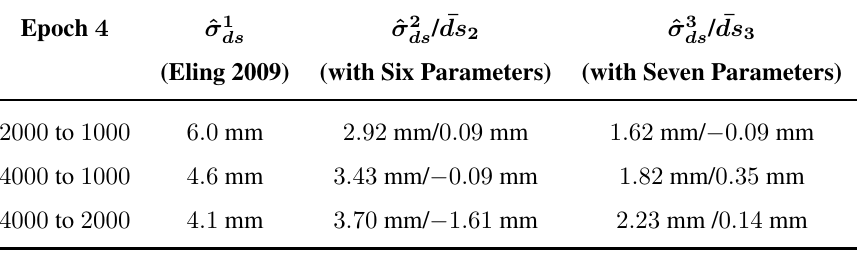
, ˆ σ 2 and ˆ σ 3 are the mean ds ds ds 2